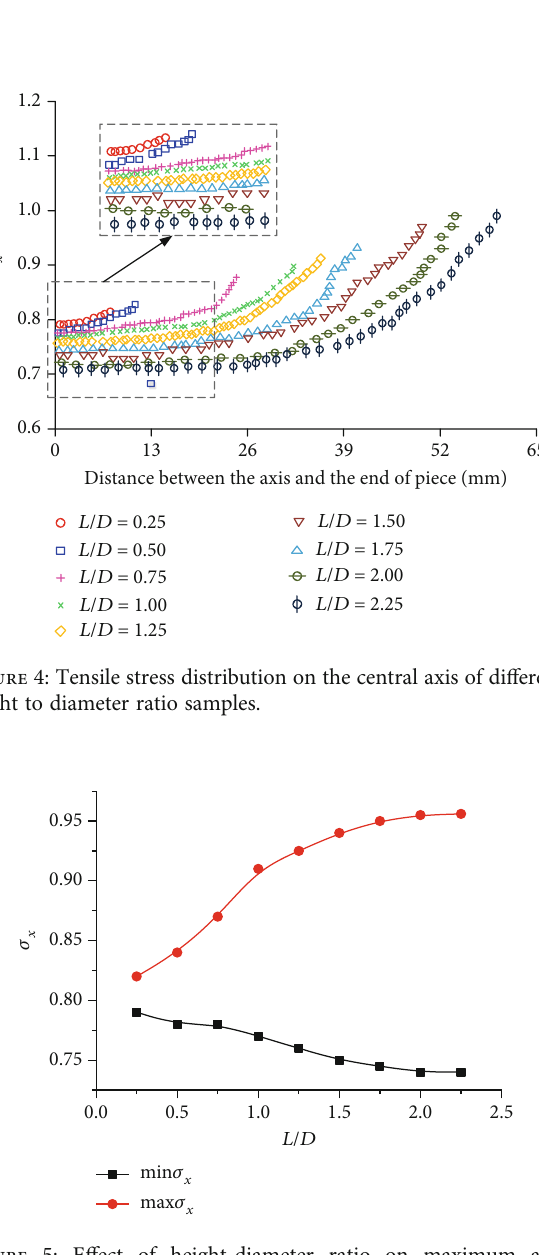
Figure 5: E ff ect of height-diameter ratio on maximum and minimum tensile stress of axial center of specimen.